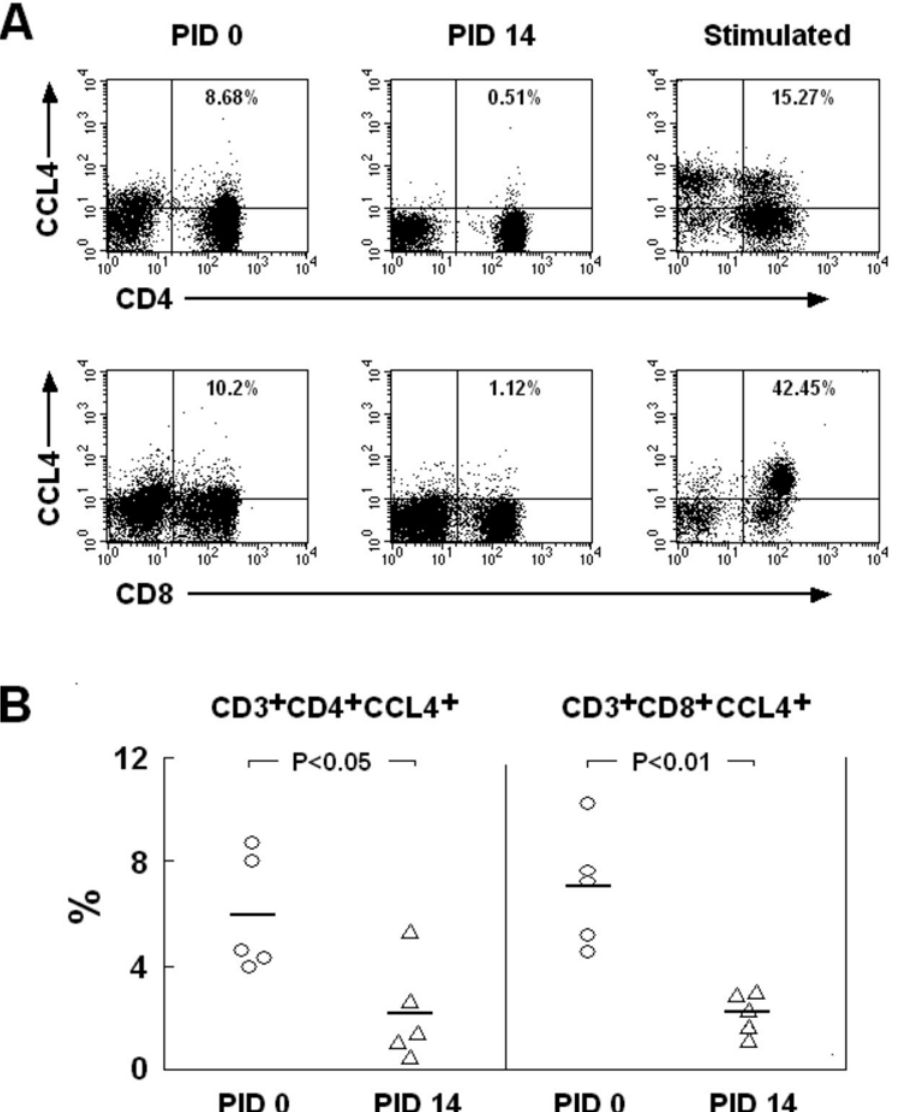
Figure 5. The proportions of peripheral blood CD3 + CD4 + CCL4 + and CD3 + CD8 + CCL4 + T lymphocytes were compared at PID 0 and PID 14 with SHIV SF162P4 by flow cytometry (A). Gating was performed via CD3 + lymphocyte population. Statistically significant differences between CD3 + CD4 + CCL4 + and CD3 + CD8 + CCL4 + cells over CD3 + lymphocytes at PID 0 vs. PID 14 (n=5) are shown